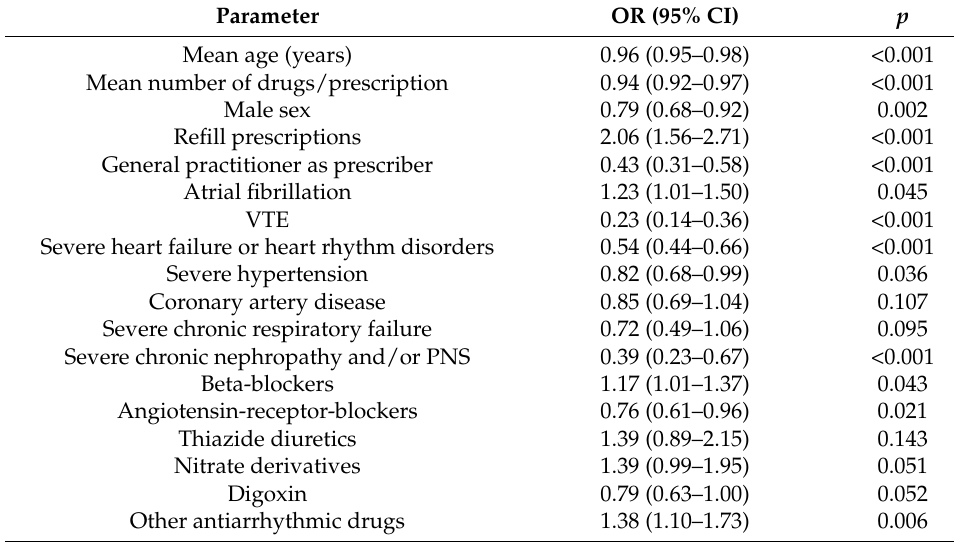
Table 3. Comparison of selected parameters in subjects prescribed direct oral anticoagulants or vitamin K antagonists, using multivariate analyses by logistic regression. The results should be interpreted from the DOAC